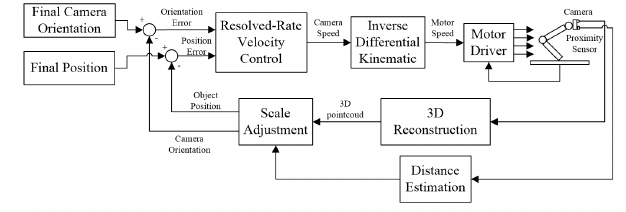
Figure 12. PBVS controlloop